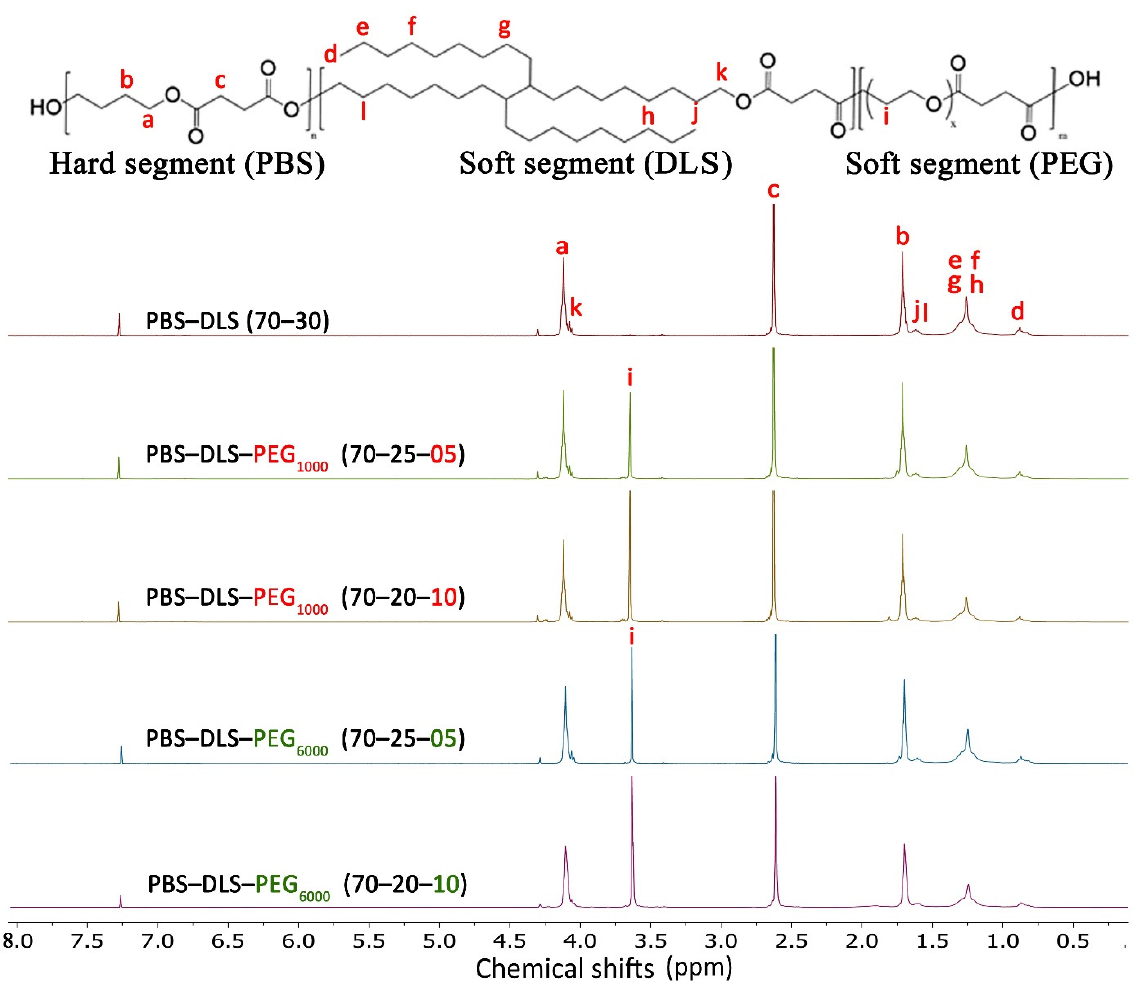
Figure 2. 1 H NMR spectra of synthesized PBS-DLS, PBS-DLS-PEG 1000 and PBS-DLS-PEG 6000 of different segmental compositions.